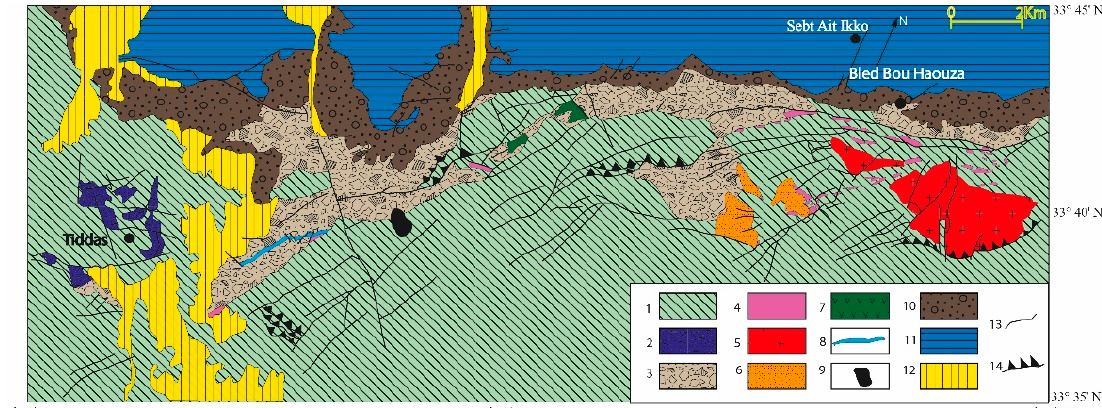
Figure 2. Geological map of the TSESDAI volcanic complex and its environs (based on [28], completed by [29,38]): 1. Upper Visean Paleozoic terrains (schists and quartzites); 2. pyroxene andesties (Tiddas andesites); 3. Permian conglomerates, sand- stones, and argillites; 4. biotite rhyolite dikes; 5. biotite rhyolitic dome (Ari Almahsar and Agrued El khebiza); 6. pyroxene dacites (Bled Bou Haouza); 7. olivine and pyroxene andesites (Sebt Ait ikko); 8. pyroxene dolerite vein; 9. pyroxene basalt flows of El Gitoune; 10. Triassic detrital and volcanic formations; 11. Messinian and Pliocene conglomeratic and marl formations; 12. Quaternary; 13. undefined faults; 14. inverse